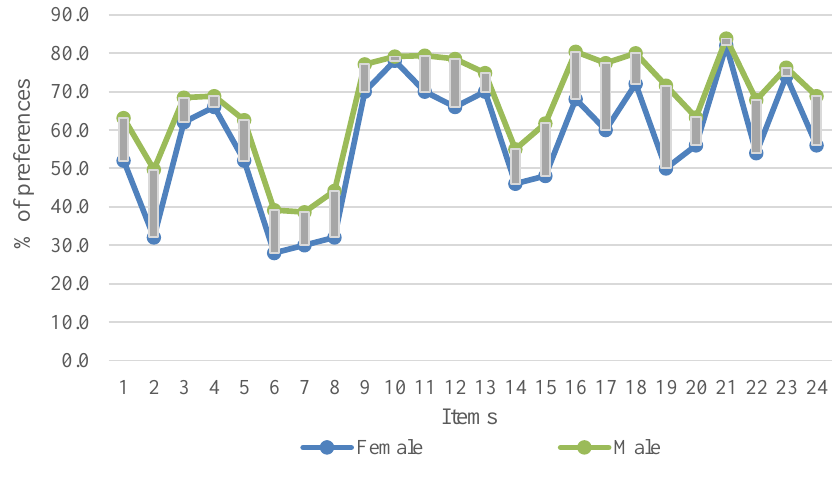
Fig. 1. Percentage of preferences of the different items related to university teachers' percep- tions of EOL by